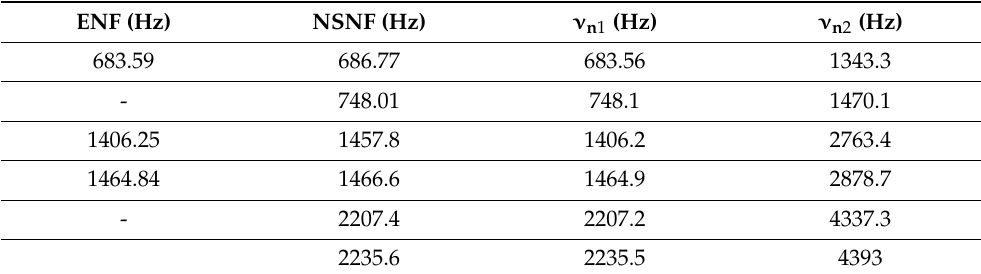
Table 4. Comparison of the experimental natural frequencies (ENFs) of the driveshaft and numerical simulations using the finite element analysis (FEA) program Ansys of the natural frequencies (NSNFs) in [13] with those obtained for the midshaft based on Equations (57) and